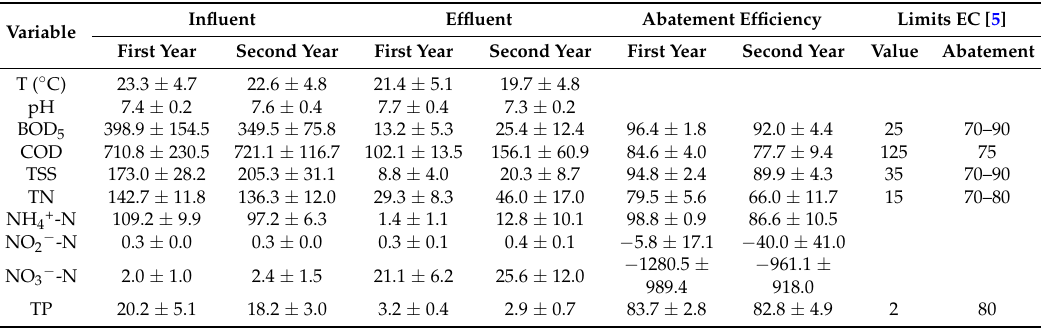
Table 1. Concentration values (mean ± sd in mg · L − 1 ), abatement efficiency (%) and the legal limits for discharge of the monitored parameters in the HF-CW